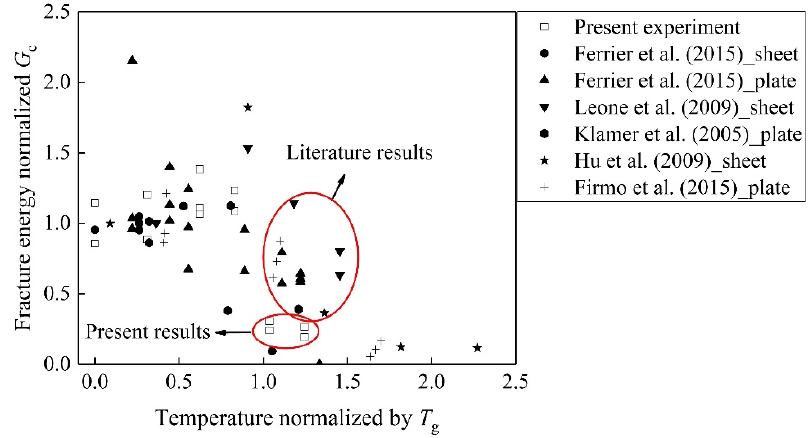
Figure 11. Fracture energy normalized by G c vs. temperature at surface of BFRP normalized by T g .